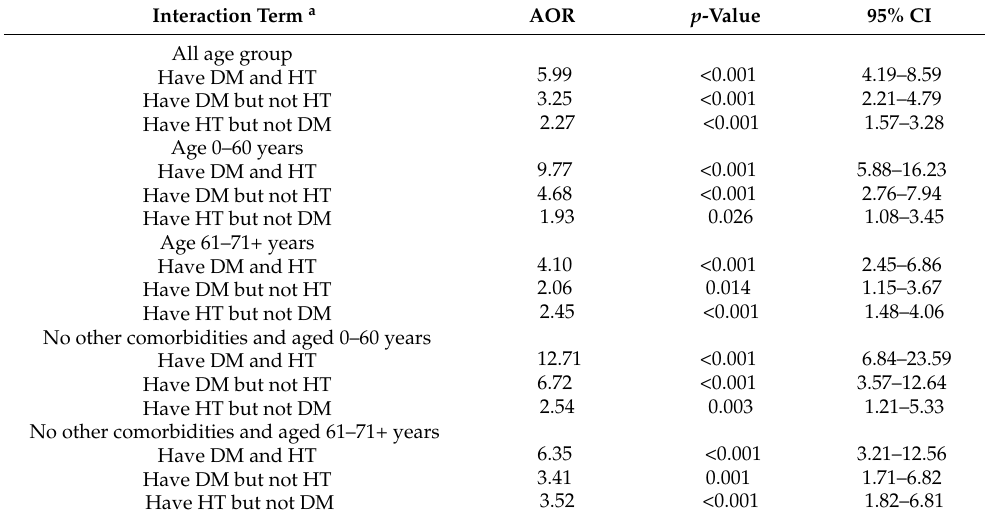
Table 3. Interaction result between diabetes mellitus and hypertension on COVID-19 in-hospital mortality stratified with age